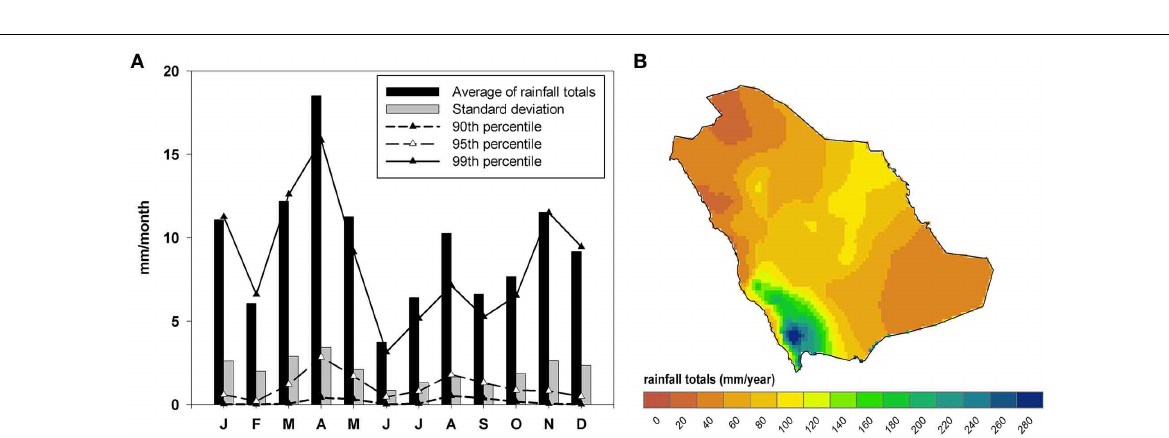
FIGURE 2 | (A) Monthly accumulated rainfall for Saudi Arabia (black bars) and the corresponding standard deviation (gray bar), compared to a set of percentiles (90th, 95th, and 99th) calculated for the 1960–2005 period. Panel (B) shows the spatial distribution of the annual rainfall totals (mm) averaged from 1960 to